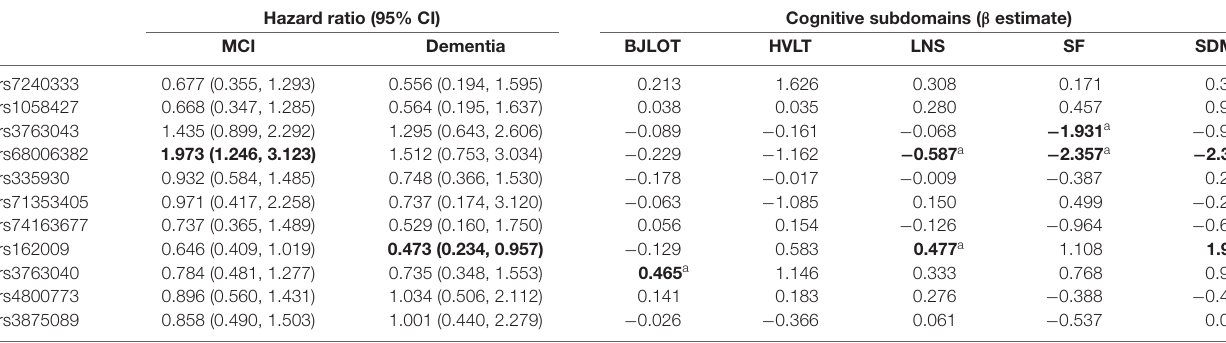
TABLE 3 | AQP4 SNPs and cognition in patients with PD.